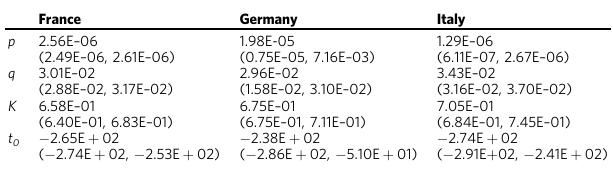
Table 1 Estimated parameters of the innovation diffusion model for France, Germany, and